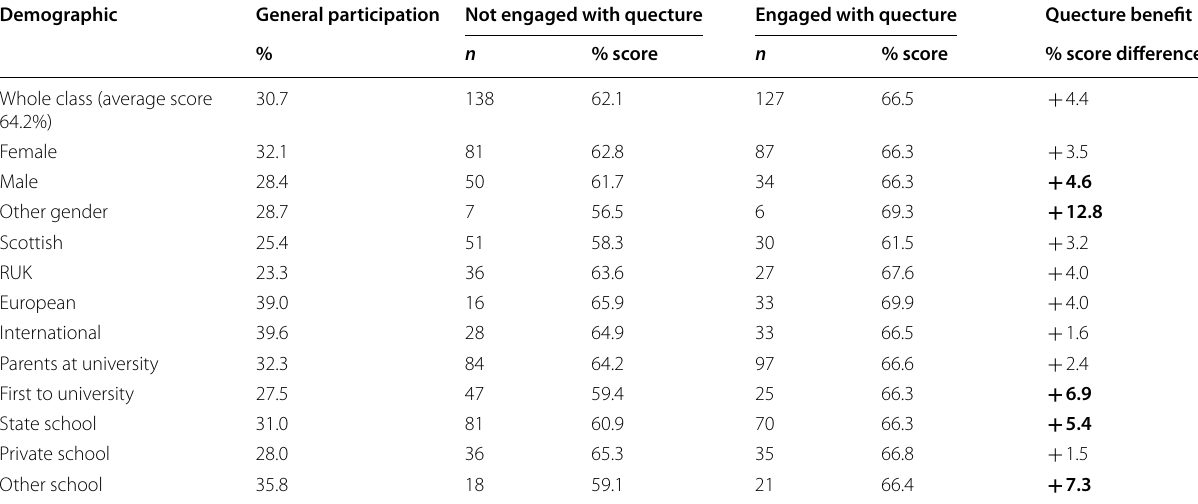
Quecture benefit is the difference between the average % score for those that engaged with quectures and those that did not. Bold values in the quecture benefit column denote score differences that exceed those for the whole class